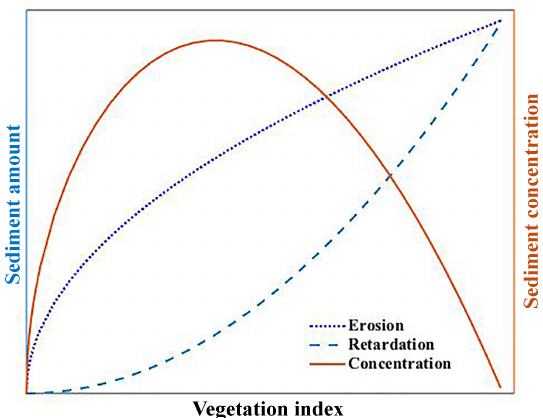
Figure 4. Illustration of the correlation between vegetation and sed- iment erosion, retardation, and the resulting sediment concentration in the YRB. Since vegetation usually increases with discharge, with the rise in discharge, sediment eroded and delivered by streamflow increases rapidly, while the retardation from vegetation is limited at the beginning and increases fast afterwards. This non-synchronous impact on sediment transport leads to the bell shape correlation be- tween sediment concentration and